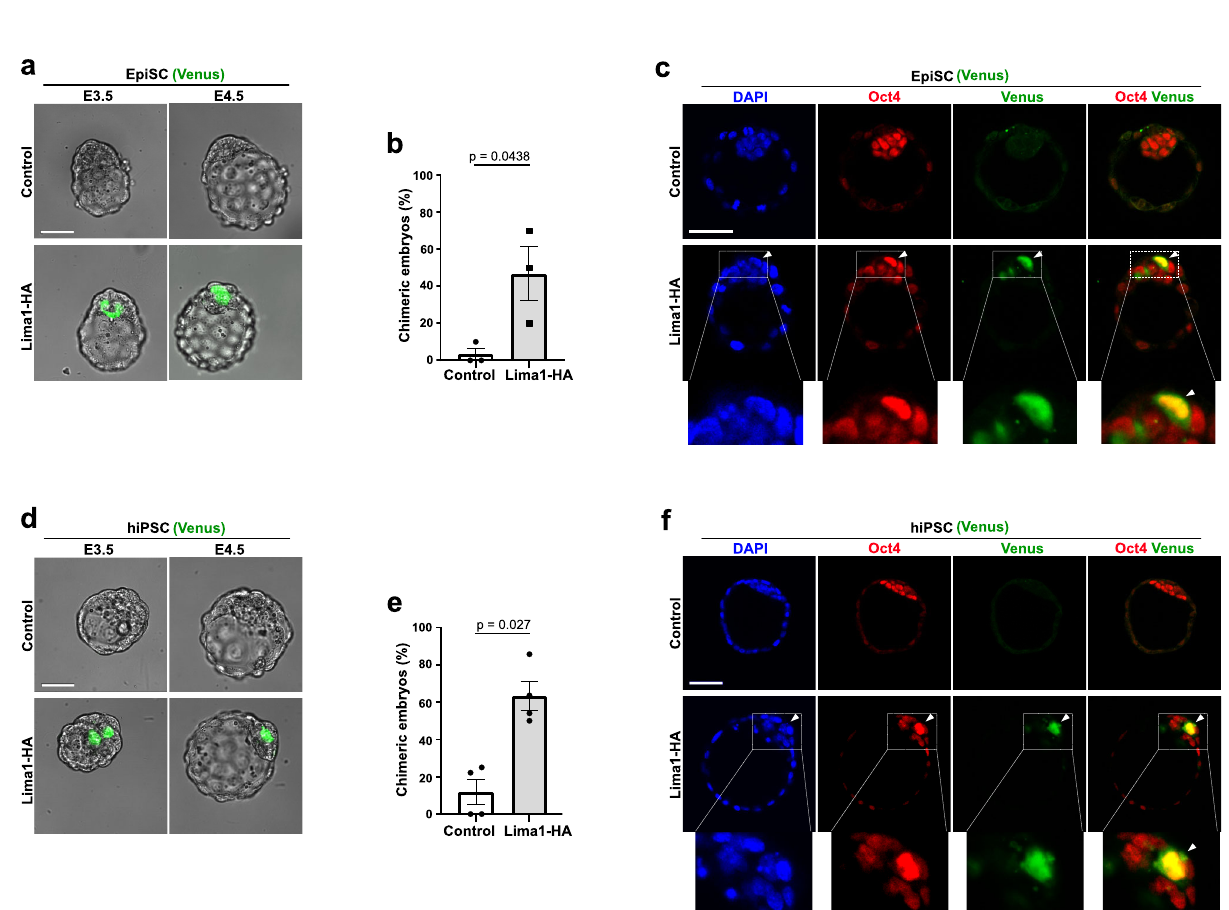
Fig. 8 Engraftment of Lima1-HA-expressing primed pluripotent cell in mouse pre-implantation embryos. a E3.5 and E4.5 chimeric blastocysts generated via morula aggregation using control or Lima1-HA-expressing EpiSC. b Quanti fi cation of the chimeric blastocysts containing control (22 embryos) or Lima1- HA-expressing (26 embryos) EpiSC at E4.5. Data represent mean ± SEM, n = 3 independent experiments, unpaired Student ’ s t -test, 2-sided. c Chimeric blastocysts generated via morula aggregation using control (upper panel) or Lima1-HA-expressing EpiSC (lower panel) and stained for Venus, Oct4 and DAPI. Arrowhead indicates integrated EpiSC. d E3.5 and E4.5 chimeric blastocysts generated via morula aggregation using control or Lima1-HA-expressing conventional hiPSC. e Quanti fi cation of the chimeric blastocysts containing control (30 embryos) or Lima1-HA-expressing (33 embryos) conventional hiPSC at E4.5. Data represent mean ± SEM, n = 4 independent experiments, Mann – Whitney test, 2-sided. f Chimeric blastocysts generated via morula aggregation using control (upper panel) or Lima1-HA-expressing conventional hiPSC (lower panel) and stained for Venus, Oct4 and DAPI. Arrowhead indicates integrated hiPSC. Scale bars, ( c ), ( f ), 20 μ m. Experiments were repeated independently three times ( a, c, d ) with similar results. Related to Fig.